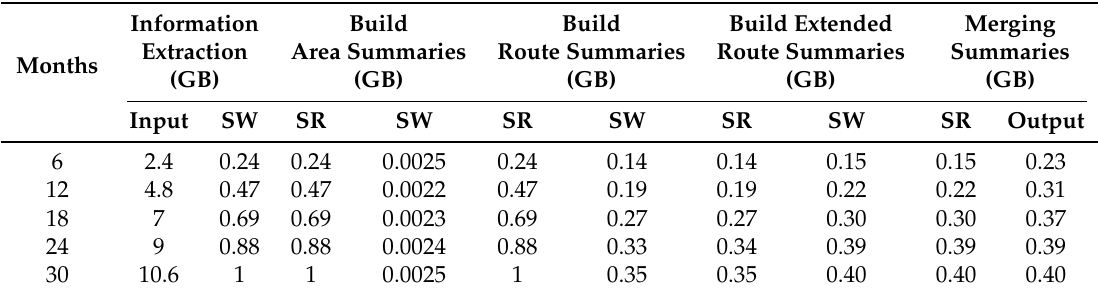
Table 4. Distributed data flow of Chicago dataset’s PQ-index